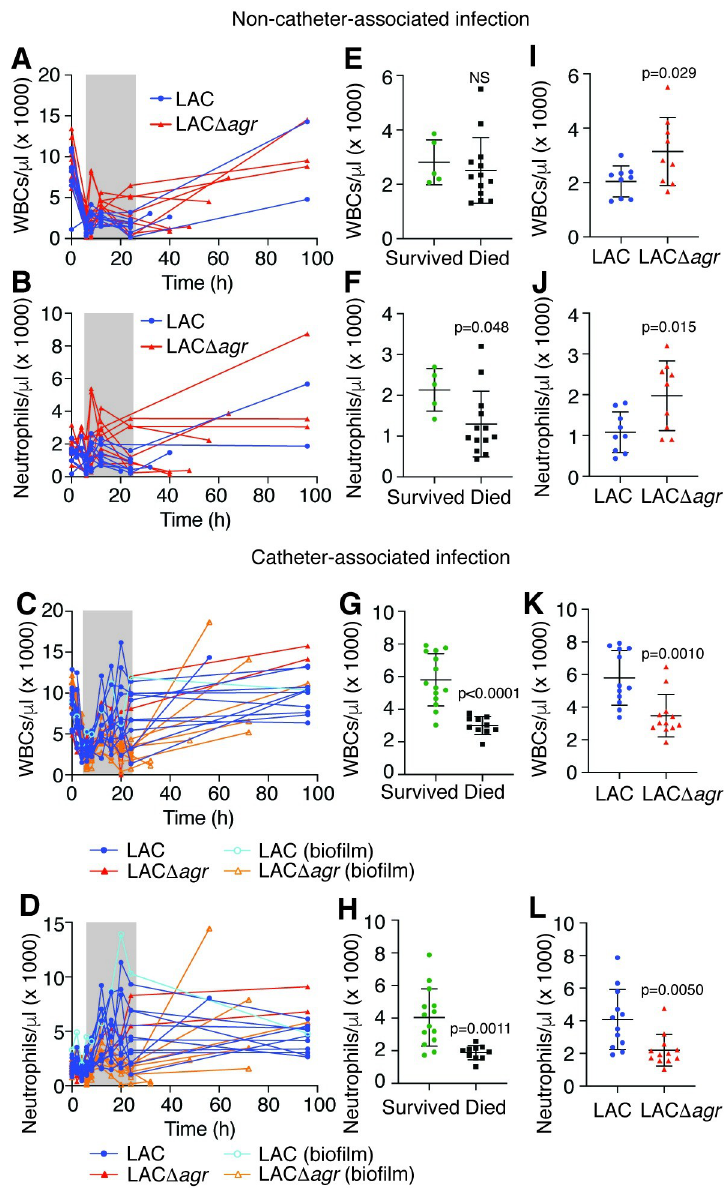
Fig 5. Rabbit sepsis models–leukocyte numbers. ( A-D ) WBC and neutrophil numbers over time in the non-catheter- associated ( A,B ) and catheter-associated ( C,D ) model. ( C,D ) Rabbits that developed catheter biofilms are marked by open symbols and light-colored borders. ( E-H ) Analysis of death versus survival outcome based on the averages of leukocyte numbers of every animal in the time window 6–24 h (grey shading) in panels A-D. ( I-L ) Analysis of impact of Agr status on the averages of WBC and neutrophil numbers in the time window 6–24 h (grey shading) in panels A through D. ( E-L ) Statistical analysis is by unpaired two-tailed t-tests. Error bars show the mean ± SD. NS, not significant (p � 0.05). See S2 Fig for monocyte and lymphocyte